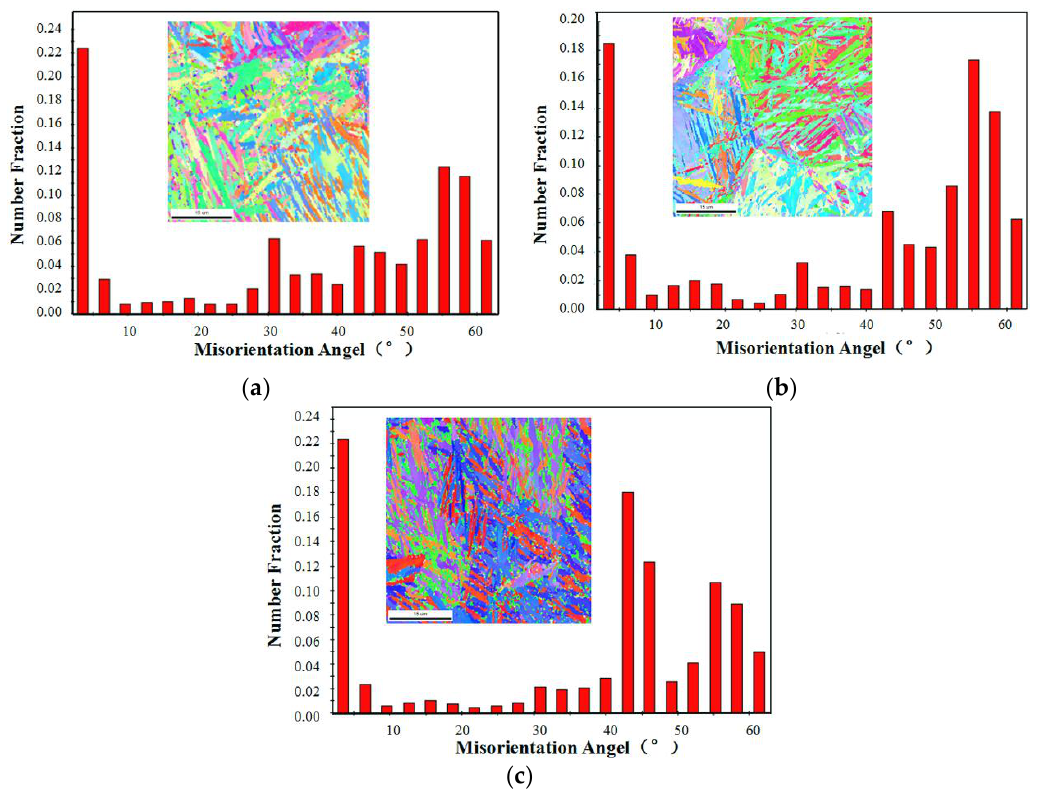
Figure 7. The boundary misorientation angle statistical column graphs of the experimental steel after different isothermal process. ( a ) 220 °C × 3 h + tempering, ( b ) 220 °C × 7 h, and ( c ) 220 °C × 15 h.